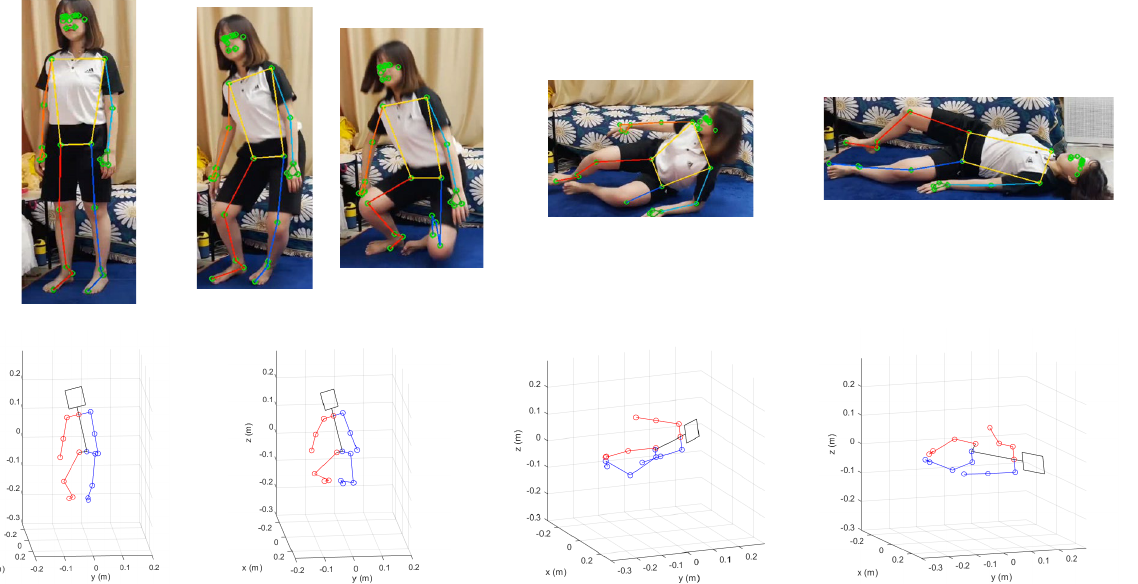
Figure 8. Results of MPP execution for a sudden falling motion images (upper row) and the corresponding humanoid poses reconstructed by uDEAS (lower row).